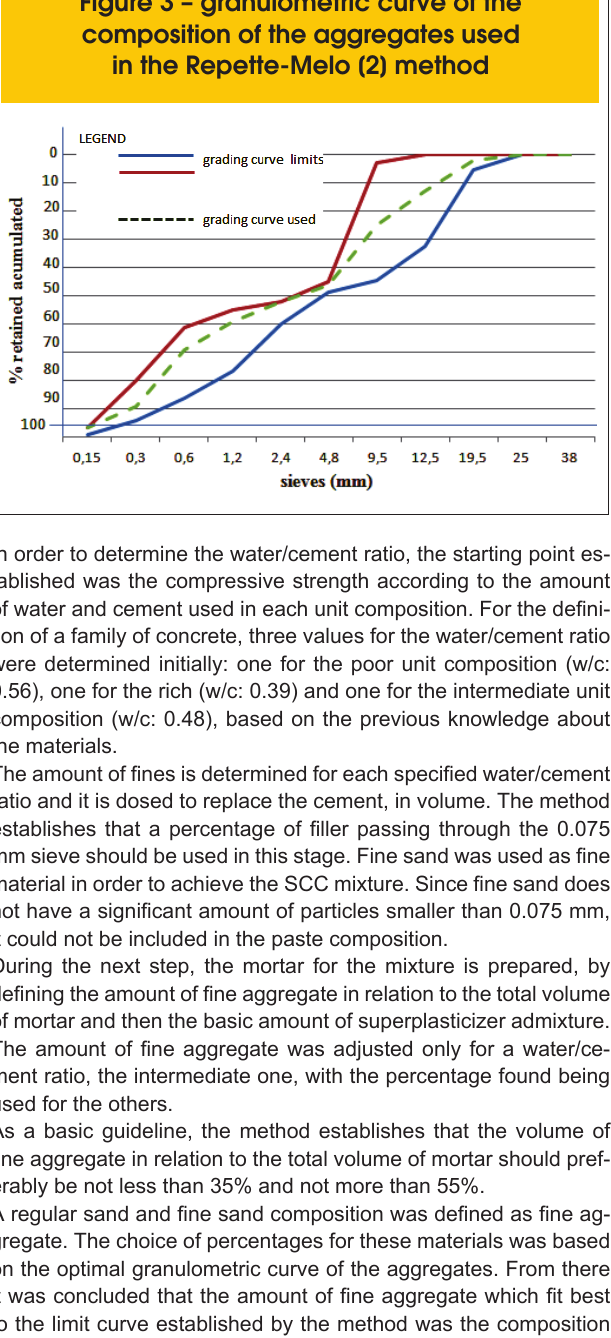
Figure 3 – granulometric curve of the composition of the aggregates used in the Repette-Melo [2]